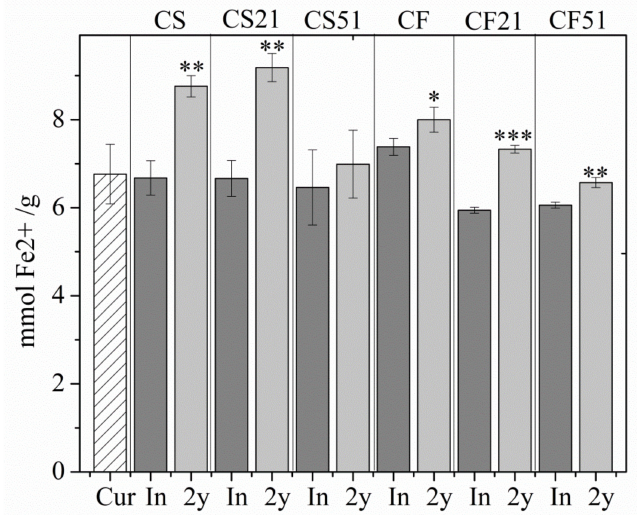
Figure 6. FRAP assay values for formulations after preparation (In) and after two years of storage (2 y). Values are shown as means ± sd ( n = 3); *, ** and ***, p < 0.05; p < 0.01 and p < 0.001 compared to the initially measured